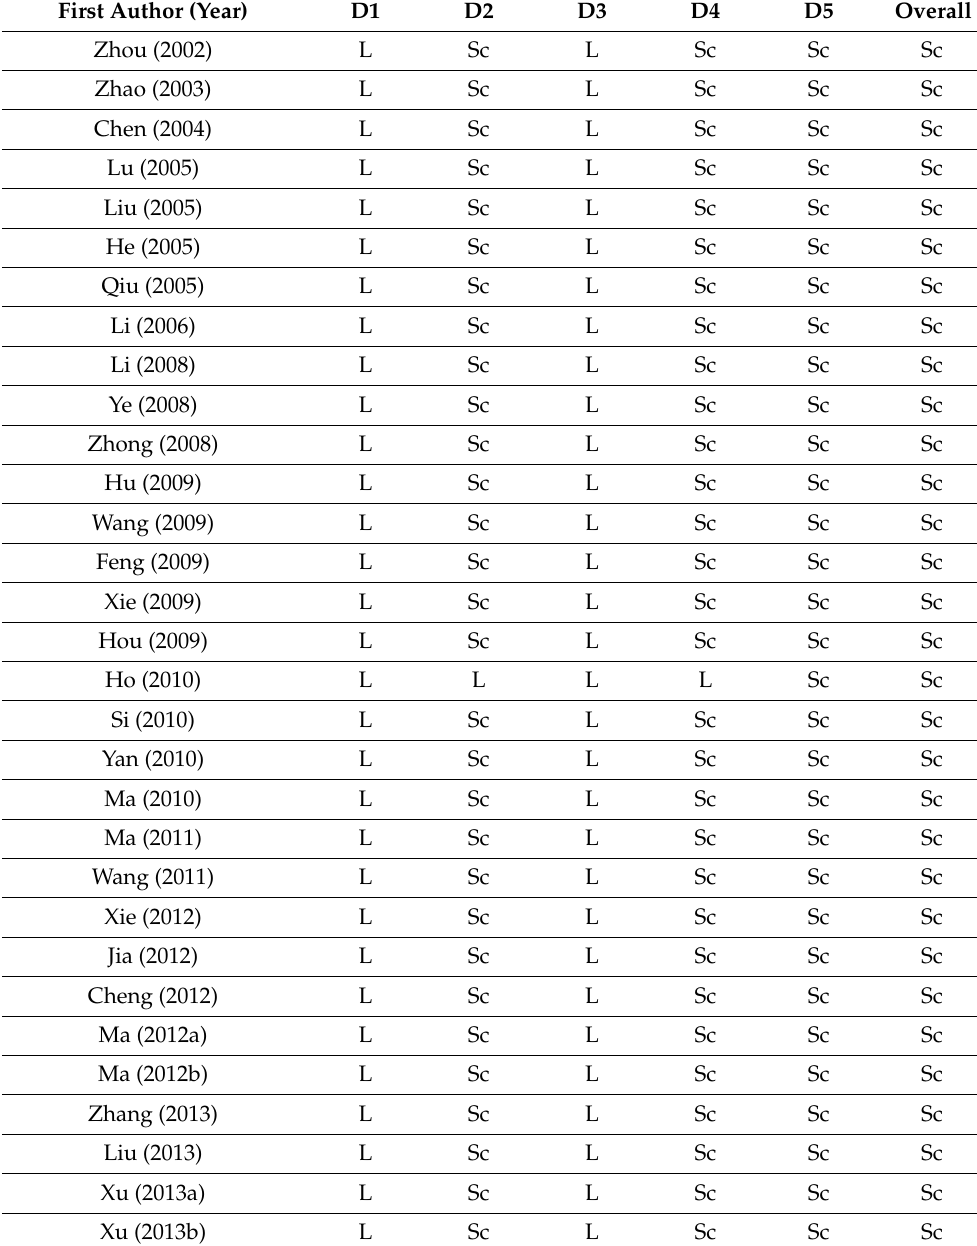
Table 2. Methodological quality of the included studies according to the risk of bias